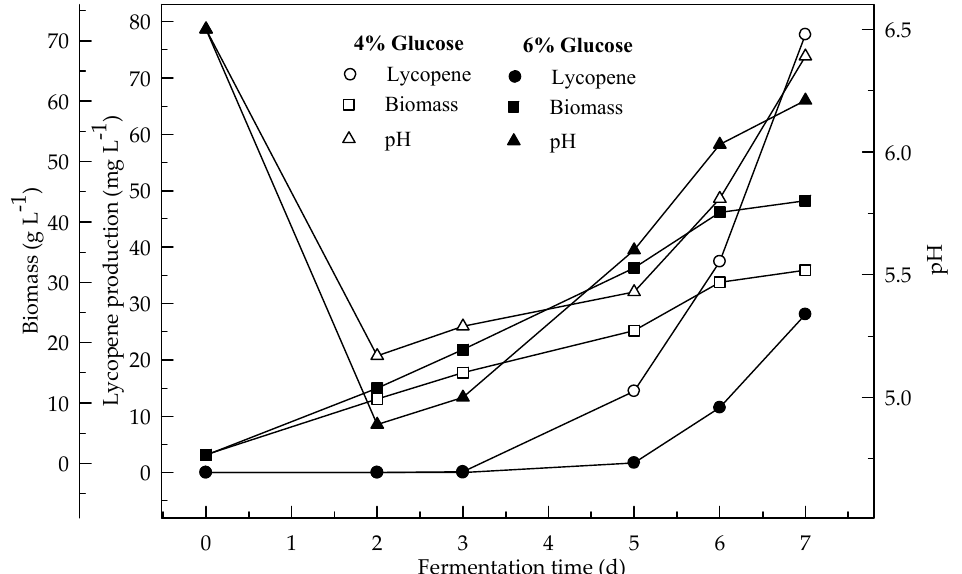
Figure 1. Changes in lycopene production, biomass formation and pH with initial pH 6.5 in a medium containing 4 and 6% glucose.